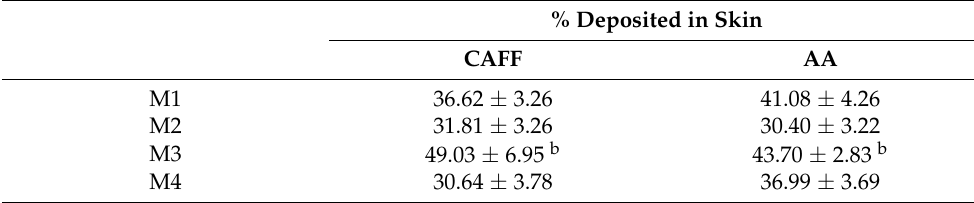
Table 9. %AA and CAFF remained in skin from different formulation a